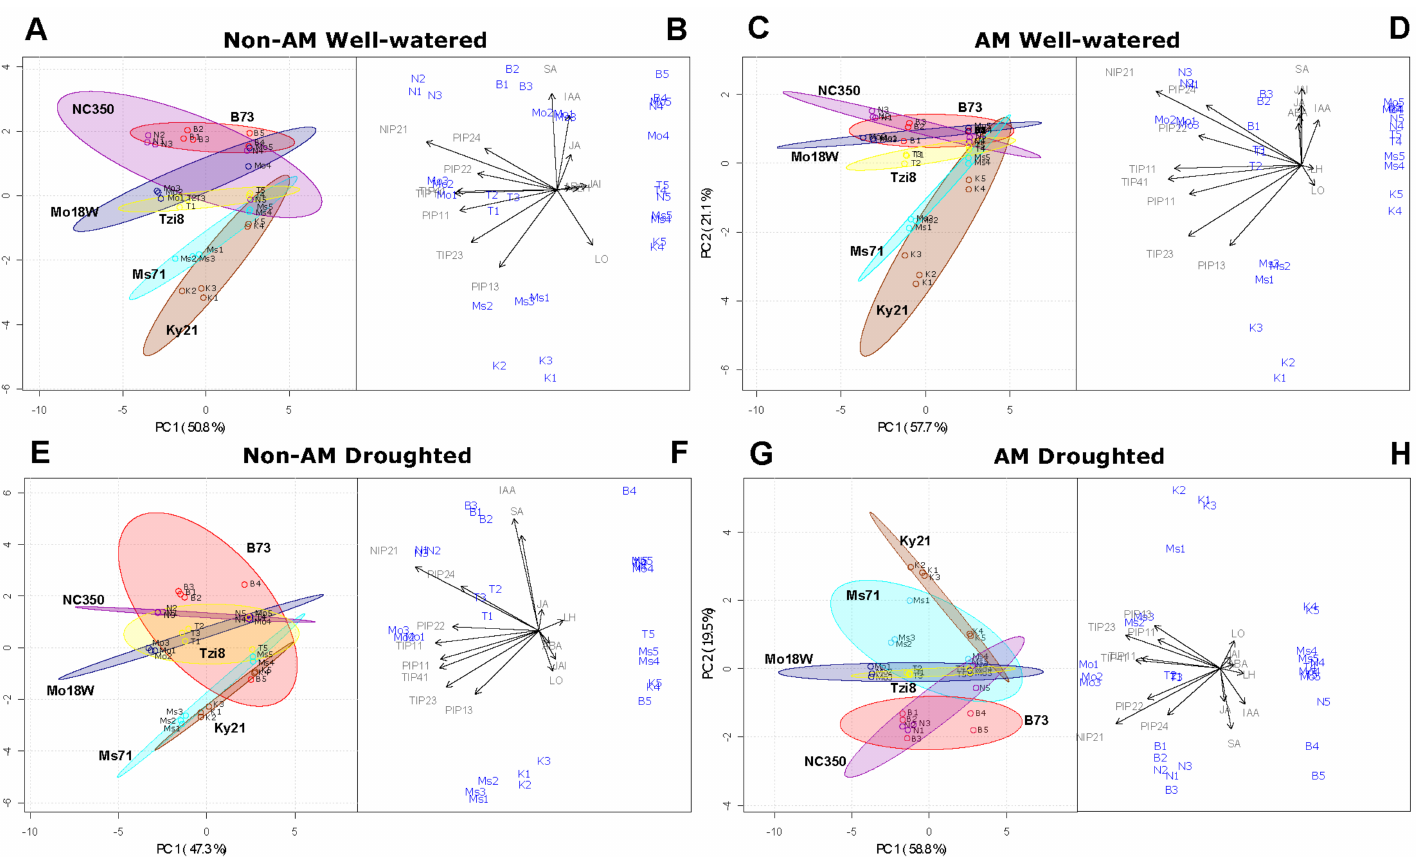
Figure 10. PCA analysis with data for Lo, Lh, sap hormonal content (ABA, IAA, SA, JA and JA-Ile) and expression of eight maize aquaporin genes regulated by the AM symbiosis ( ZmPIP 1;1, ZmPIP 1;3, ZmPIP 2;2, ZmPIP 2;4, ZmTIP 1;1, ZmTIP 2;3, ZmTIP 4;1 and ZmNIP 2;1). The analysis was conducted in six maize NAM lines (B73, Ky21, NC350, Tzi8, Ms71 and Mo18W) inoculated ( C , D , G , H ) or not ( A , B , E , F ) with an arbuscular mycorrhizal (AM) fungus. Plants were cultivated under well-watered conditions ( A – D ) or subjected to drought stress ( E – H ). ( A , C , E , G ) represent the clouds that group the different data from a given maize line. ( B , D , F , H ) represent the contribution of each measured parameter on the behaviour of the maize lines. Points labelled as B1–B5 refer to B73 data, those labelled as K1–K5 refer to Ky21 data, those labelled as N1–N5 refer to NC350 data, those labelled as T1–T5 refer to Tzi8 data, those labelled as Ms1–Ms5 refer to Ms71 data and points labelled as Mo1–Mo5 refer to Mo18W